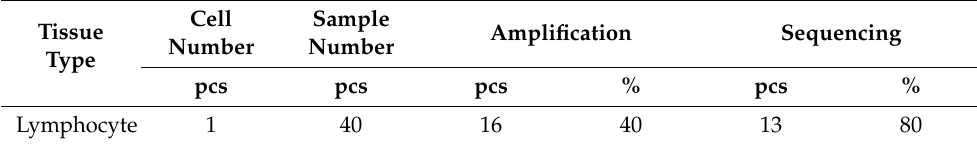
Table 5. Amplificability and sequencability of single lymphocyte cells of the cancer patient.